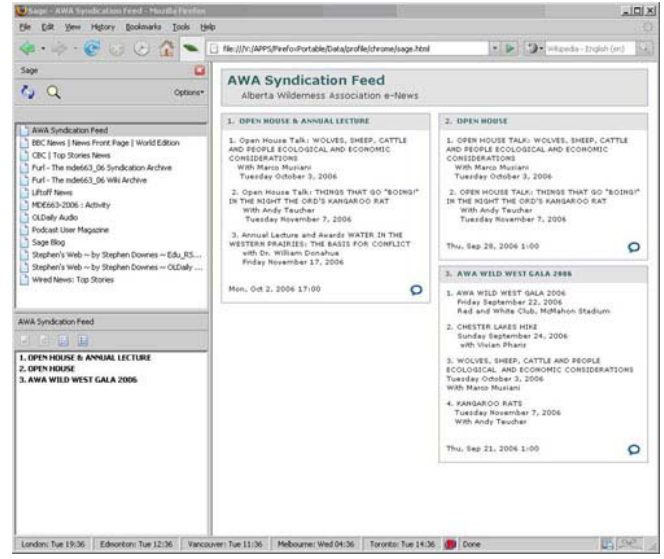
Figure 1. Web browser with a simple RSS reader add-on displaying a RSS feed with three